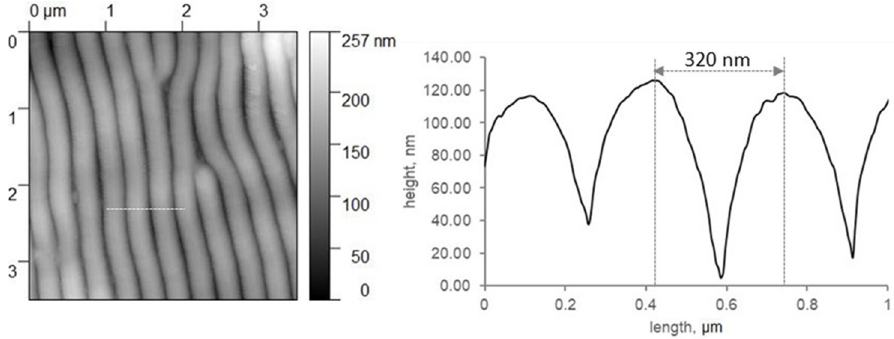
Figure 4. Non-contact AFM data to characterize the rippled LIPSS of the PET foils. The right graph shows the profile along the white line in the topography image on the left.